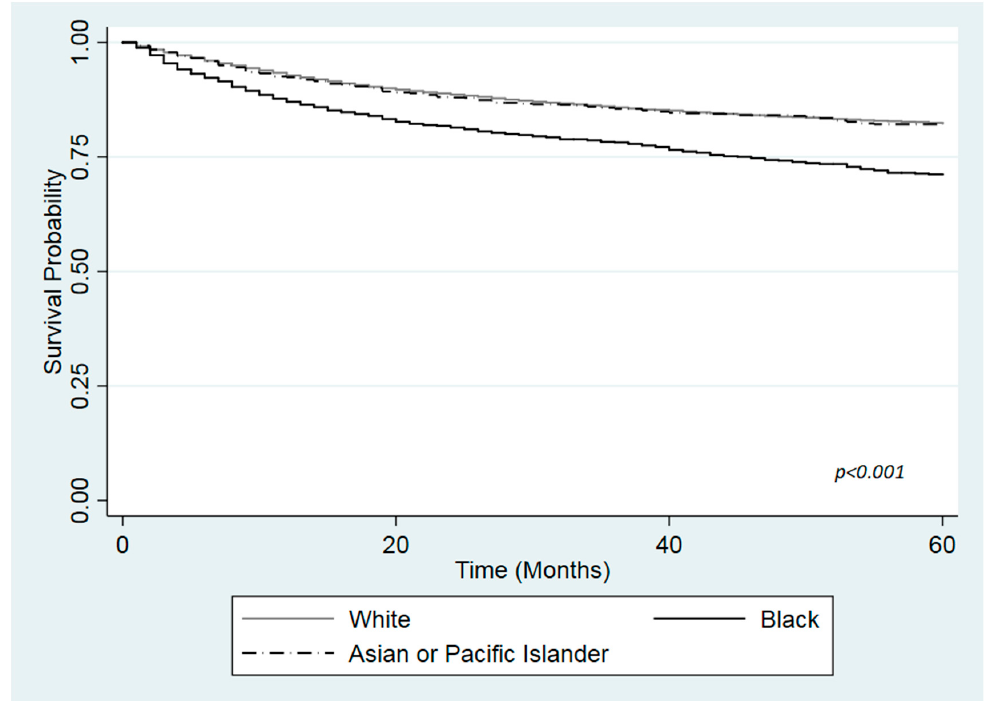
Figure 1. Kaplan-Meier curve for cause specific survival by race among insured patients with urinary bladder cancer, based on the Surveillance, Epidemiology, and End Results Program (SEER) cohort, 2007–2015.